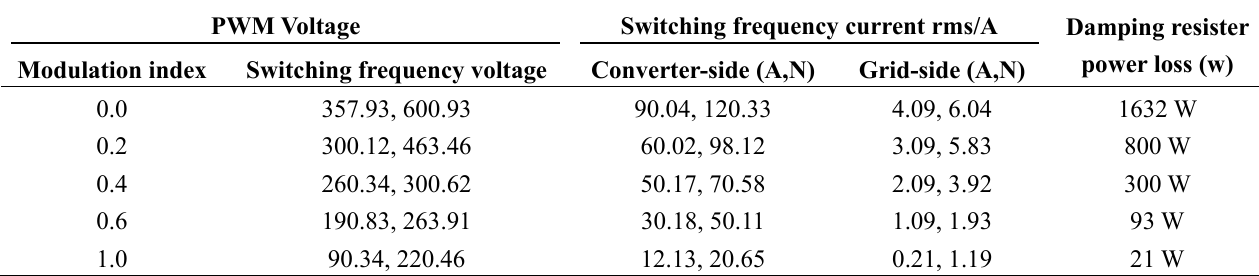
Table 5. Results of the current ripple filtering in different PWM voltage modulation